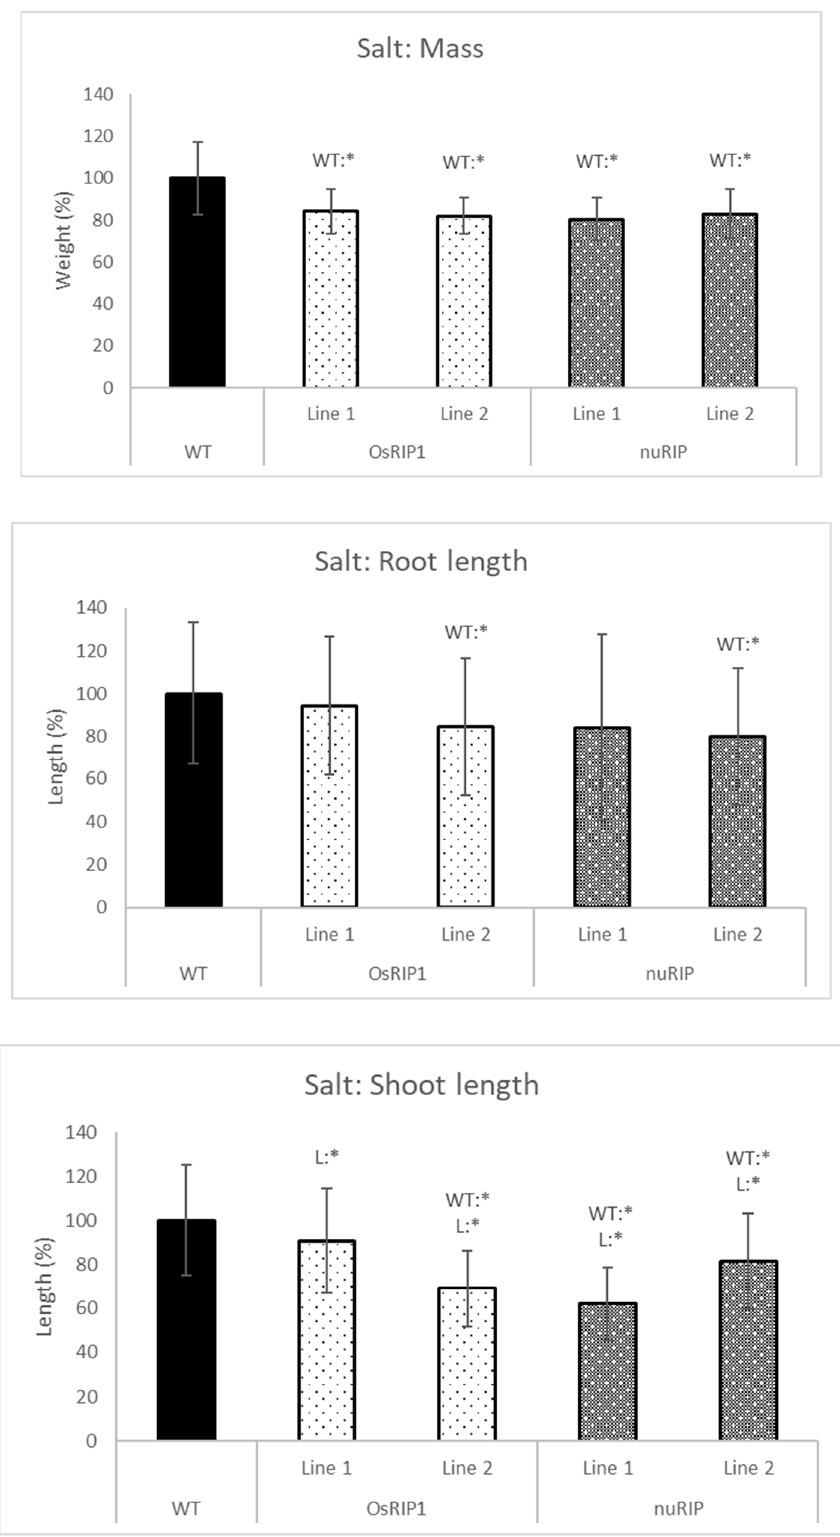
Figure 10. Total mass, shoot and root length of one-week-old plants from different transgenic lines subjected to 150 mM salt compared to those of wild-type. WT:* refers to a significant difference to wild-type plants. L:* indicates a significant difference to the other transgenic line of the same construct. The histogram is based on averages; error bars represent the standard deviation. Each data point is gathered from 50 plants per line.